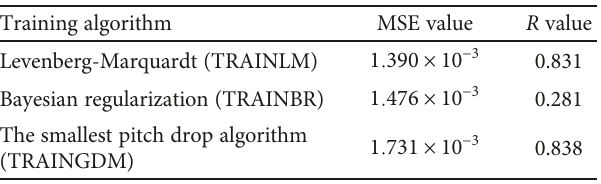
Table 6: Values of MSE and R depending on the training algorithms (for eight neurons in the hidden layer) in model ANN 2. Training algorithm